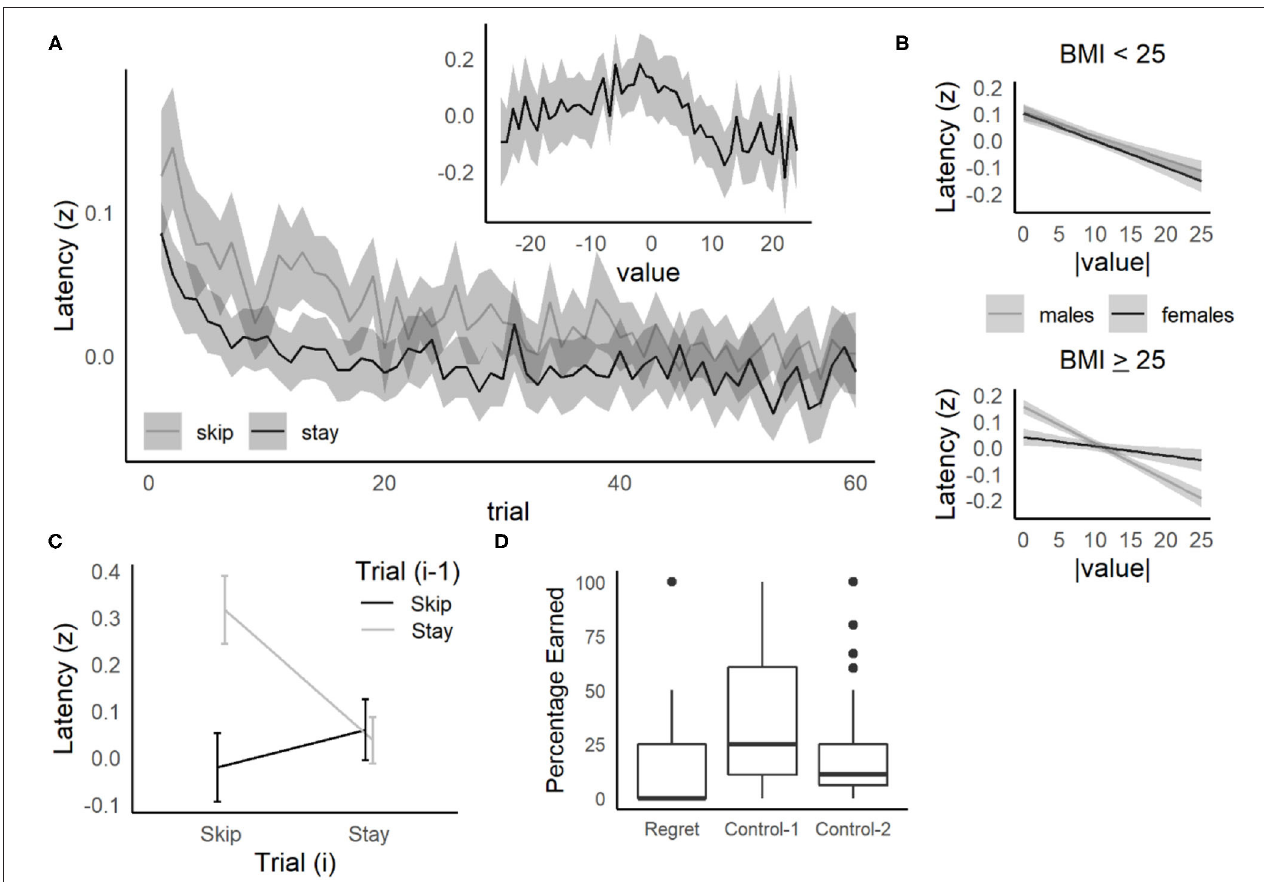
FIGURE 4 | Replication of behavioral results from the Web-Surf and Restaurant Row and relationship to BMI. (A) Decision latency relative to trial number and value (threshold—delay). The time taken to make a choice (log-transformed and z-scored) was higher overall for skip decisions, but decreased across trials for both skip and stay decisions. Inset: Decision latency was also elevated for difficult decisions (value = 0, offers near threshold). (B) Higher BMI females ( > 25–overweight/obese) were less sensitive to value compared to males with BMI > 25, and to males and females with BMI < 25. Lines and shaded area represent estimated means and 95% confidence intervals based on the regression model. (C) Sequential choice behavior. Participants were slower to accept an offer (on trial i ) after previously skipping an offer (on trial i-1 ), compared to other sequences (Skip/Skip, Stay/Stay, or Stay/Skip). (A,C) For each plot, data were averaged within participant, then means and confidence intervals were calculated across participants. Lines in C indicate means, and errorbars/shaded areas (A,C) indicate 95% confidence intervals. (D) Regret. Participants were less likely to accept low-value offers ( > threshold) in regret-inducing conditions (previously rejecting a high-value offer) compared to control conditions ( control-1 : previously accepted a high-value offer, control-2 : previously skipped a low-value offer).